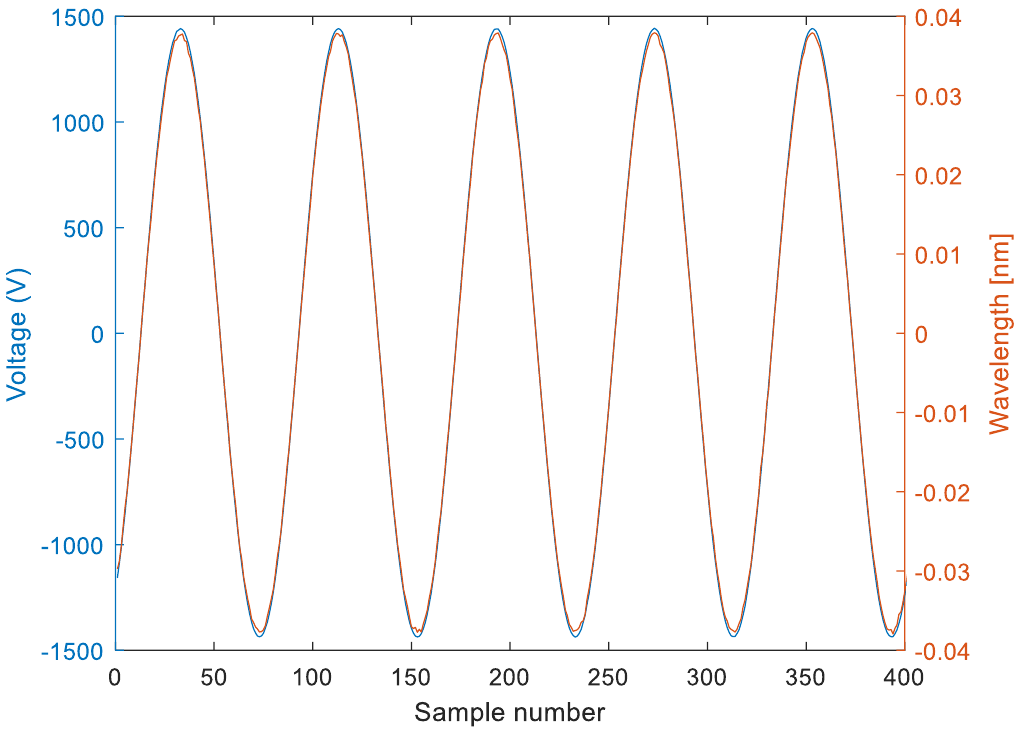
Figure 5. Instantaneous wavelength and reference voltage of the tested MVT module.